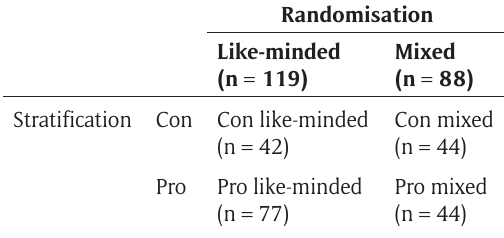
Table 1: Design of the